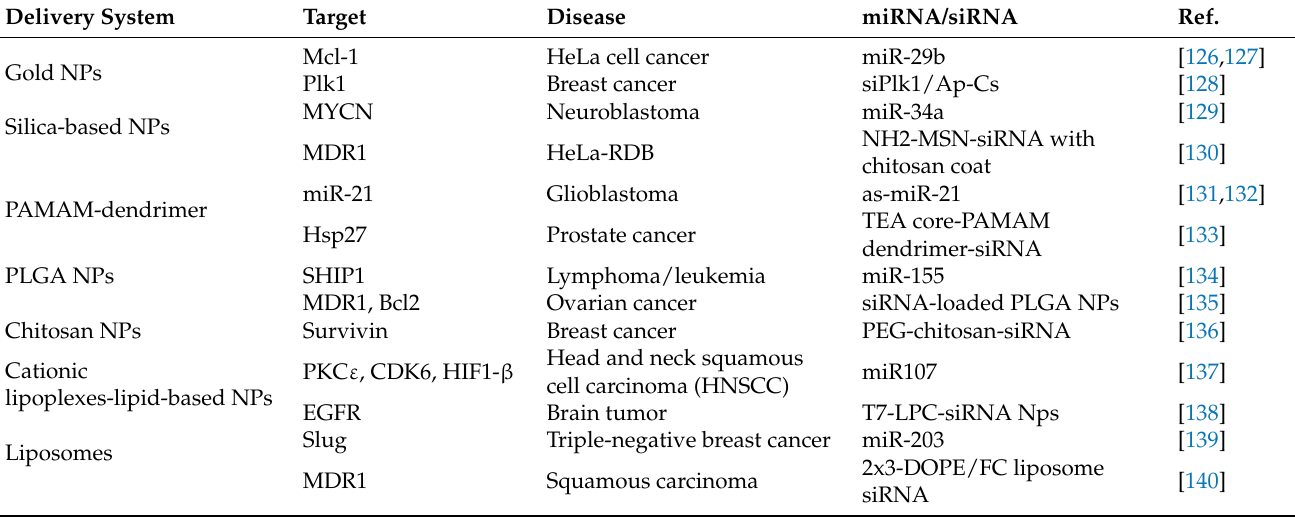
Table 2. Non-viral nanoparticle-based delivery systems for miRNA- and siRNA-based therapeutic approaches in